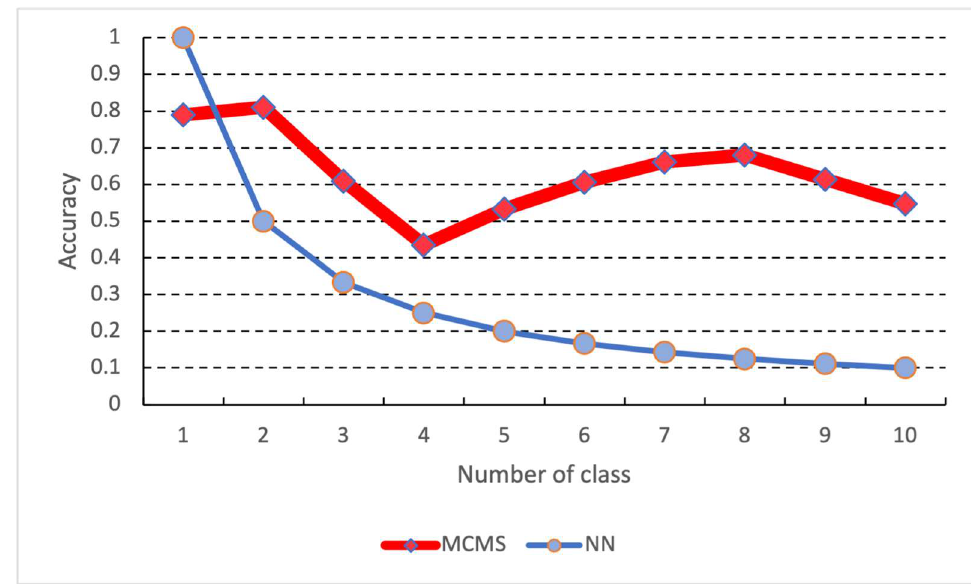
Figure 4. Comparison results between the proposed MCMS and DNN.